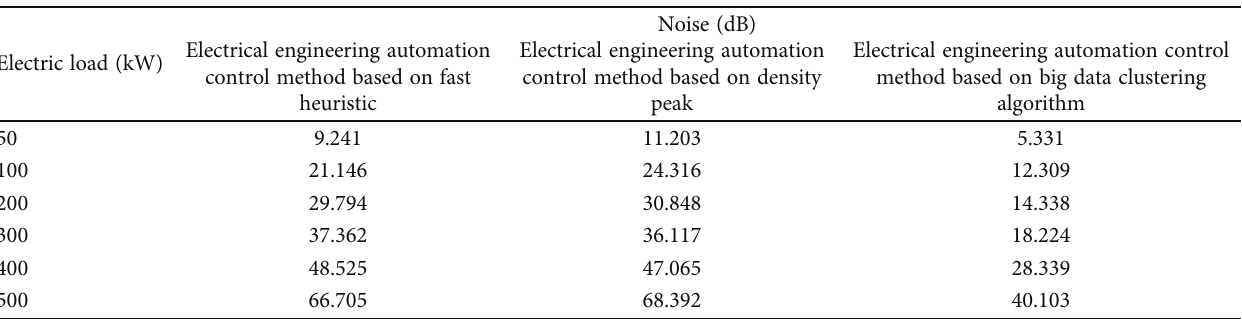
Table 1: Noise test